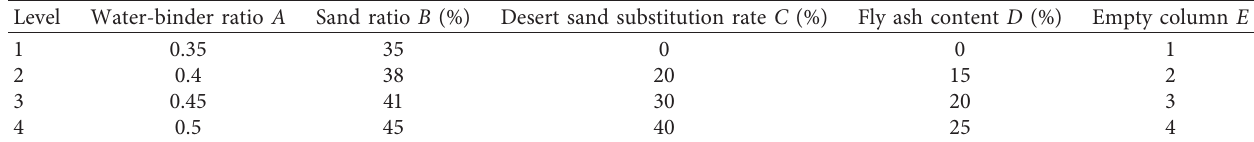
Table 6: Factor levels in orthogonal tests.